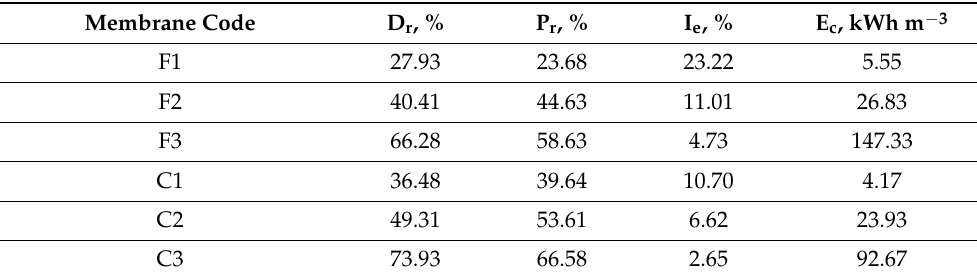
Table 2. D r , P r , I e and E c values obtained after 1 h of